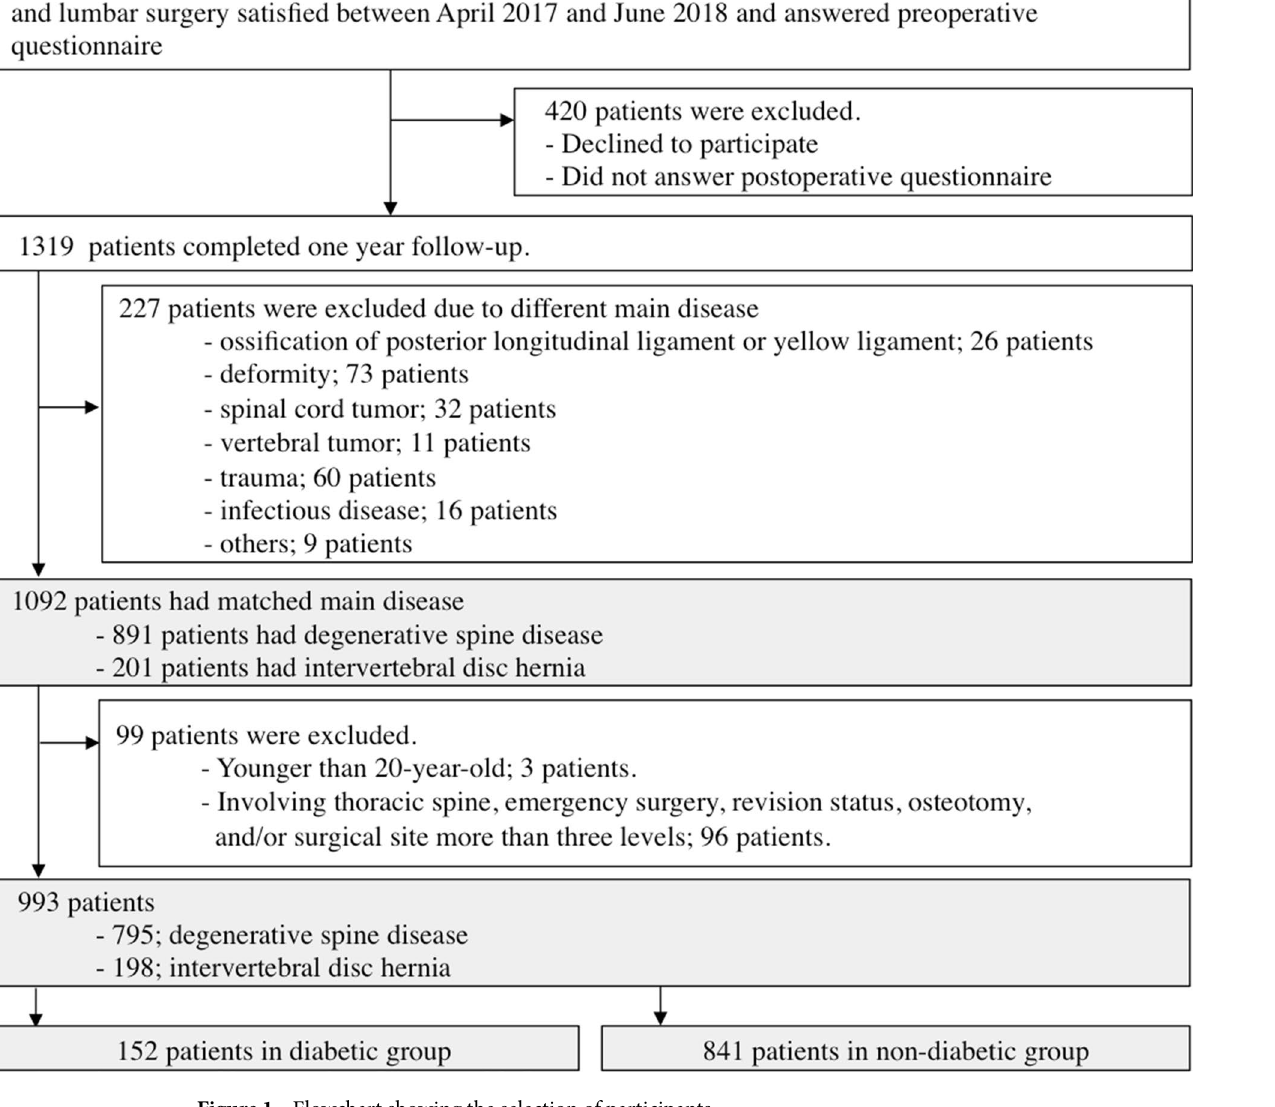
Figure 1. Flowchart showing the selection of